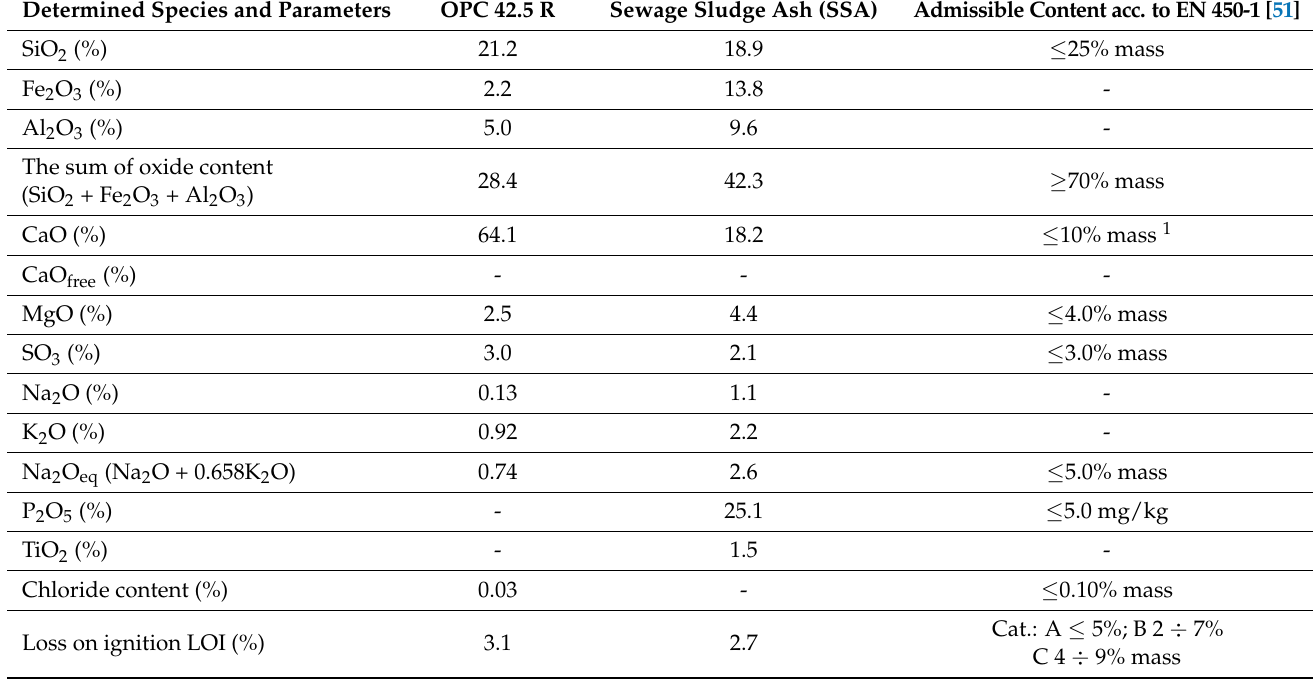
Table 2. Chemical composition of the tested raw materials (by % weight) determined via X-ray EDS. Determined Species and Parameters